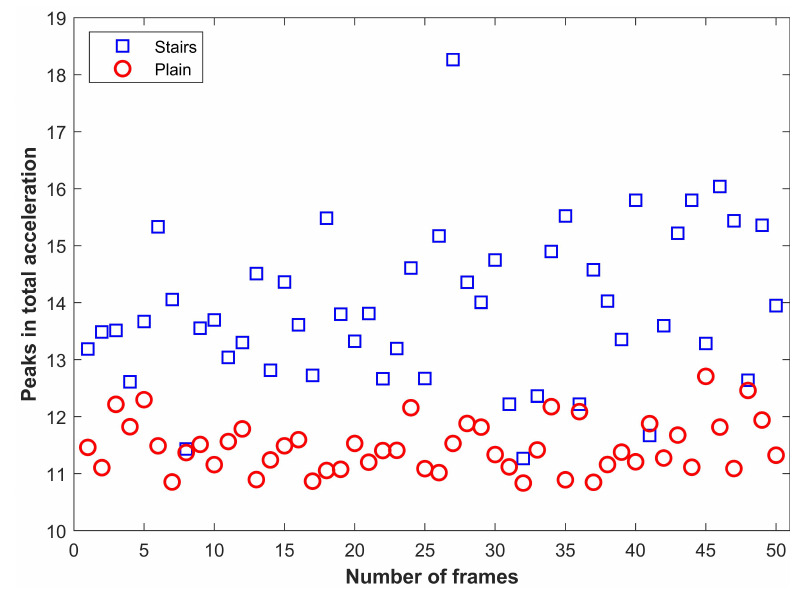
Figure 13. Maximum change in total